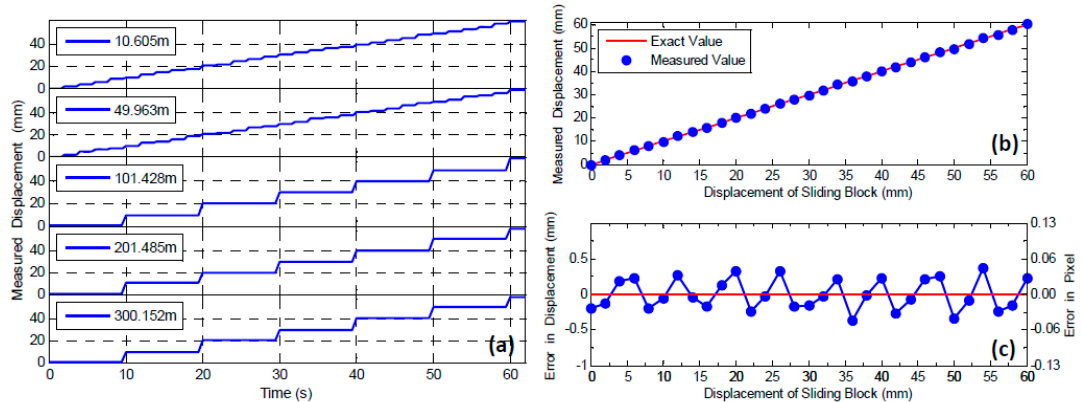
Figure 4. ( a ) Measured vertical motions of the LED target at different distances; ( b ) comparison of the measured results to the actual values at the distance of 49.963 m; and ( c ) the differences between the measured results and the actual value at the distance of 49.963 m.